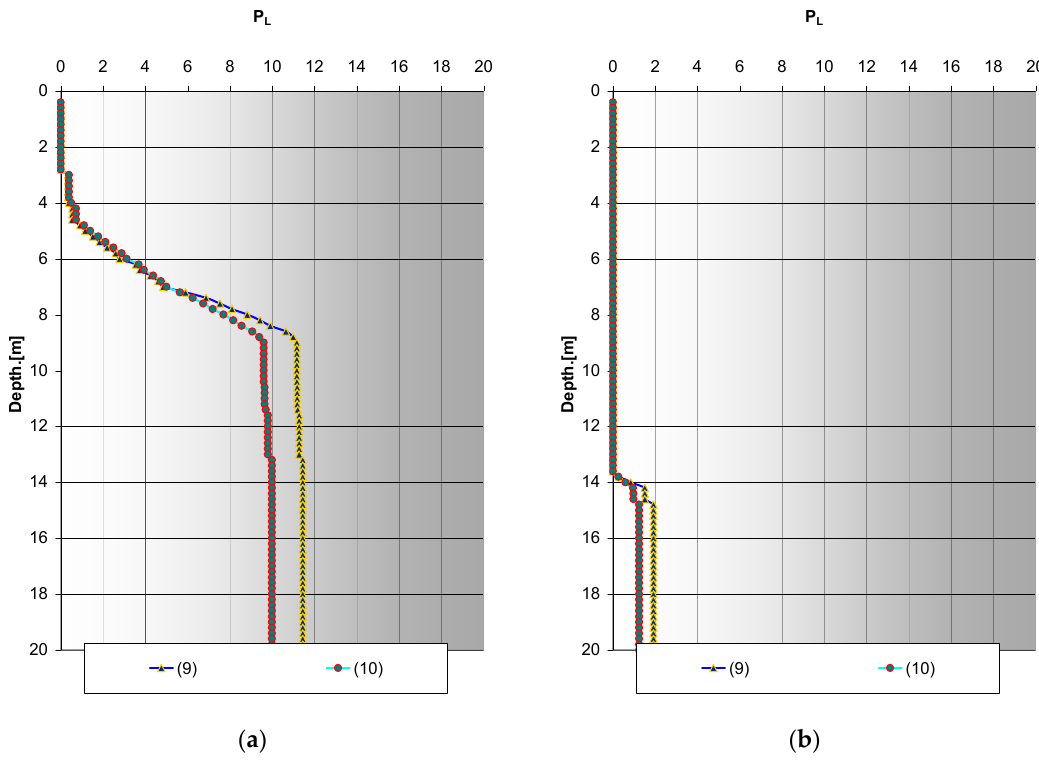
Figure 11. Evaluation of Liquefaction potential Index P L from K d data: ( a ) SDMT C; ( b ) SDMT D.